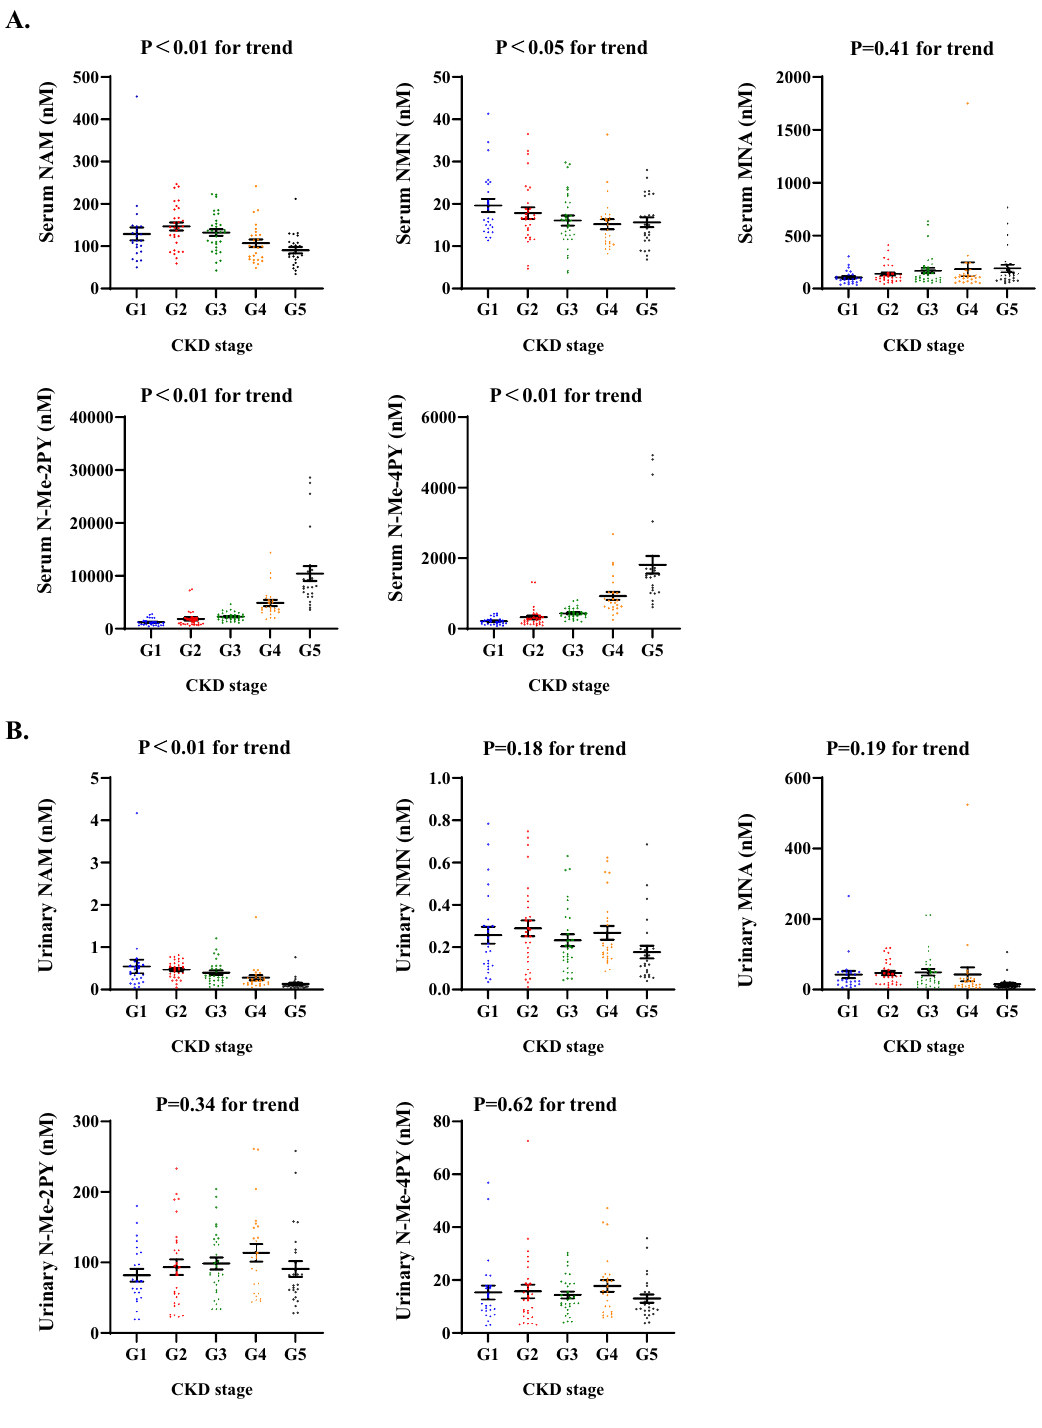
Figure 6. Serum levels of upstream metabolites of NNMT, NAM, and NMN, are reduced, while downstream metabolites of NNMT, N-Me-2PY, and N-Me-4PY are elevated with CKD progression. Scatter plots demonstrating serum ( A ) and urinary ( B ) NAD + metabolites across CKD clinical stages. The data represent means ± SEM. NAM, nicotinamide; NMN, nicotinamide mononucleotide; MNA, 1-methylnicotinamide; N-Me- 2PY, N-methyl-2-pyridone-5-carboxamide; N-Me-4PY,